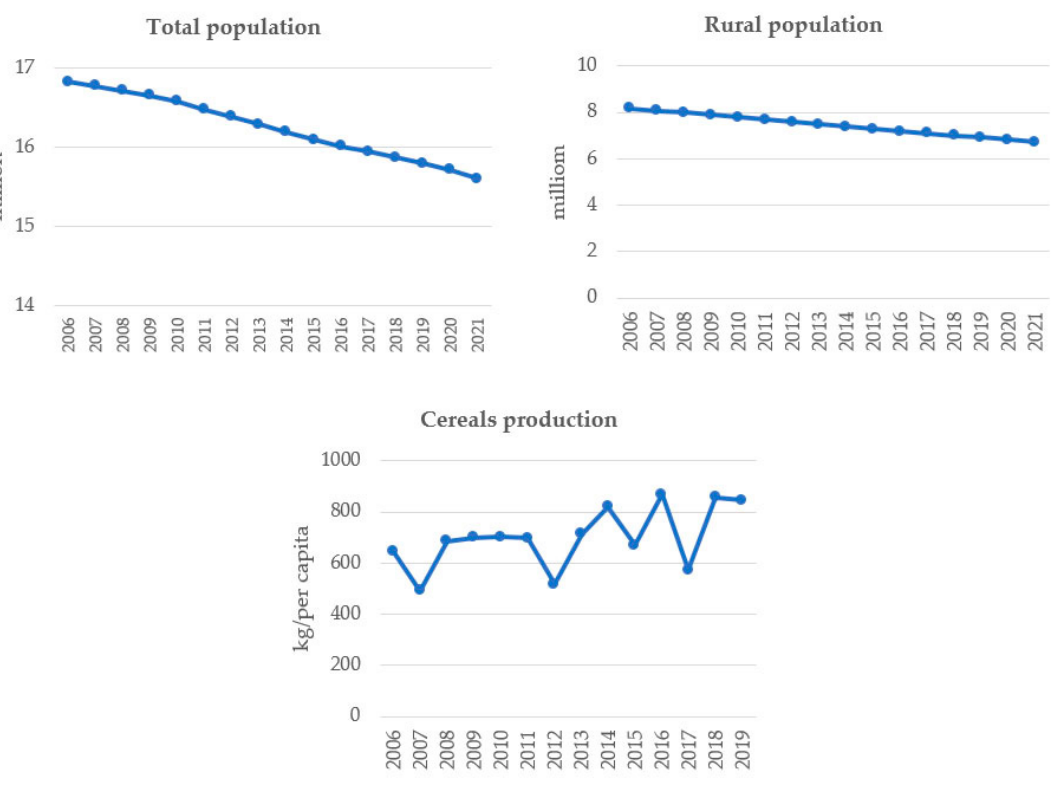
Figure 4. Evolution of total and agriculture population and cereal production in the Western Balkans. Source. The authors’ presentation on the basis of data from the World Bank [55].